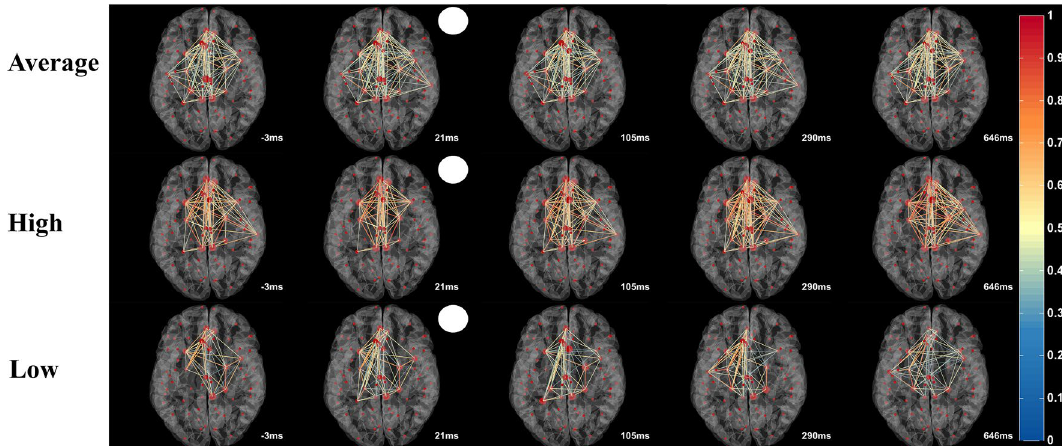
Figure 2. Imaging “Brain Spacetime” in visual processing. Transient network formations during visual processing displayed in time-slices as a function of visual stimulus onset (white circle) in averaged normal rFCN. Hubs (big red dots) represent ROIs with high synchronization (hub scores 2–4, displayed by hub size). Links between the hubs were color-plotted as a function of their weight from 0 to 1. The top row shows the averaged hub locations and their inter-hub connections in normal brains. The lower rows show two representative subjects with different levels of network synchronization (high and low). The real-time video displayed in the Supplementary Video S1 illustrate the rapid rFCN dynamics of hubs in 8 ms resolution.